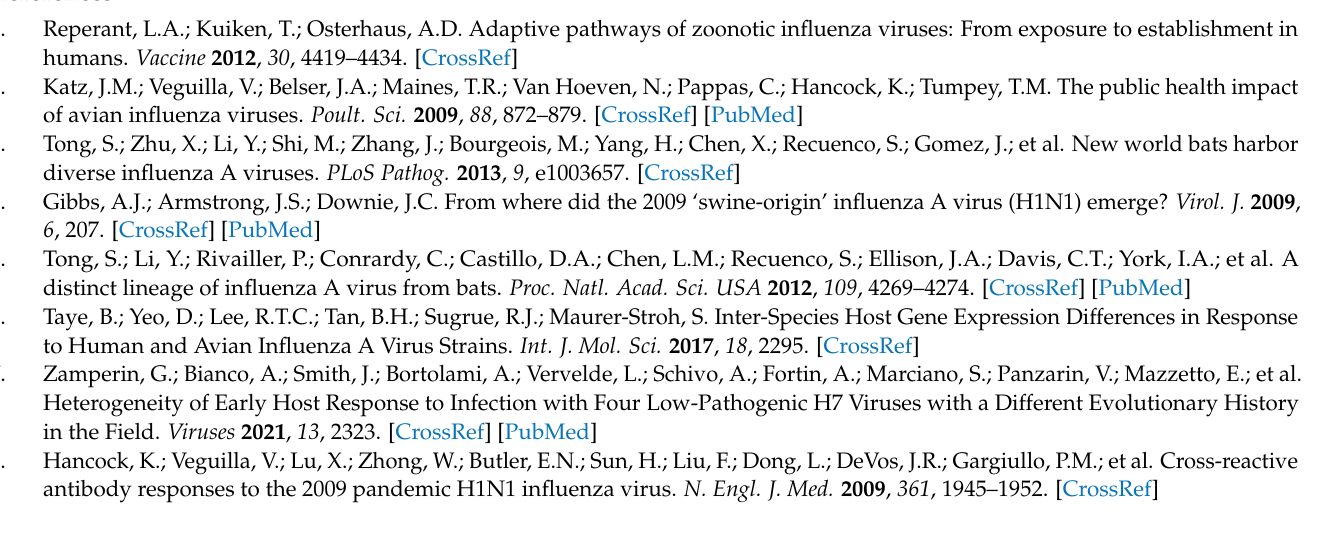
analysis, Table S5: Gene Ontology of up-regulated HPAI DEGs, Table S6: Gene Ontology of down- regulated HPAI DEGs, Table S7: Gene Ontology of up-regulated LPAI DEGs, Table S8: Gene Ontology of down-regulated LPAI DEGs, Table S9: HPAI upstream